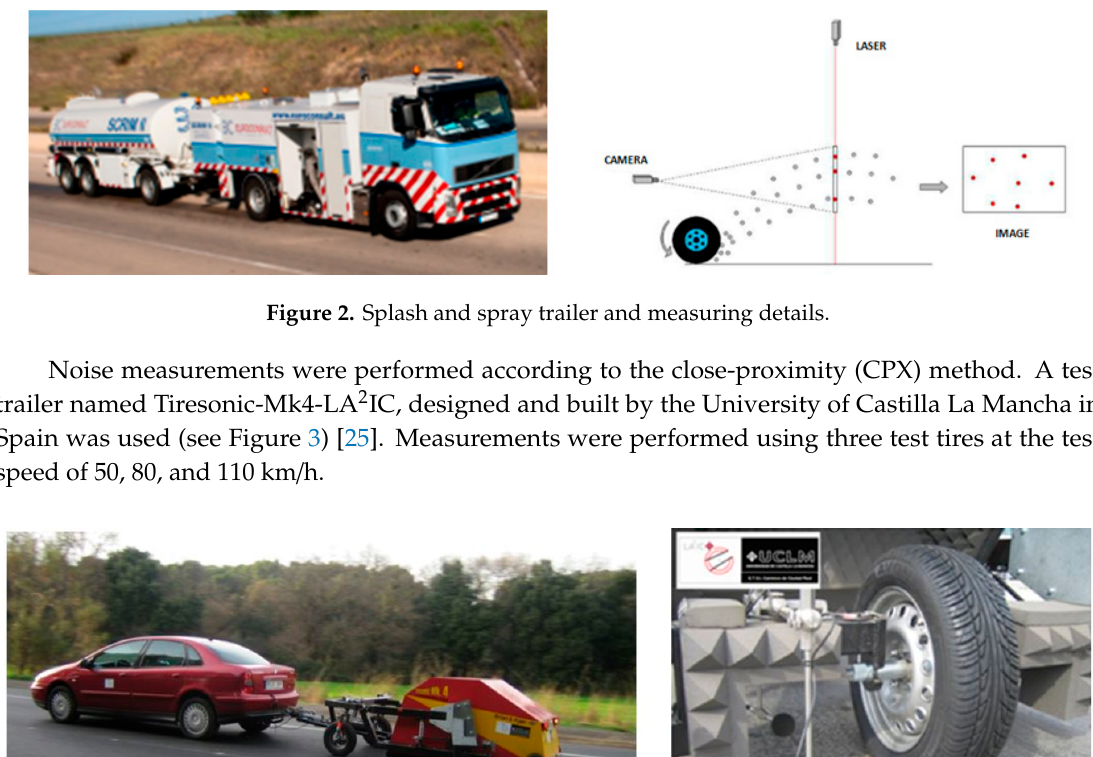
Table 1. List of considered properties for each category.